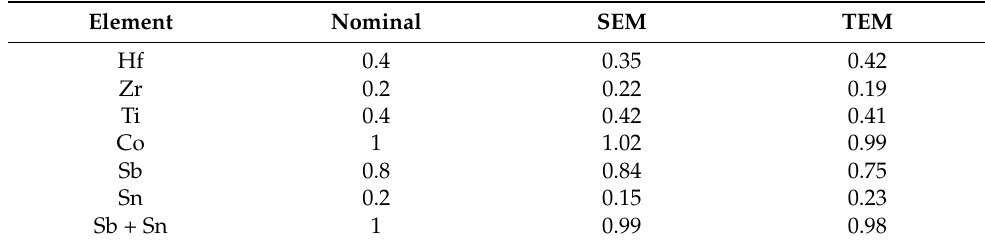
Table 3. Nominal and chemical composition of the hot-pressed Hf 0.4 Zr 0.2 Ti 0.4 CoSb 0.8 Sn 0.2 sample as determined by EDS and